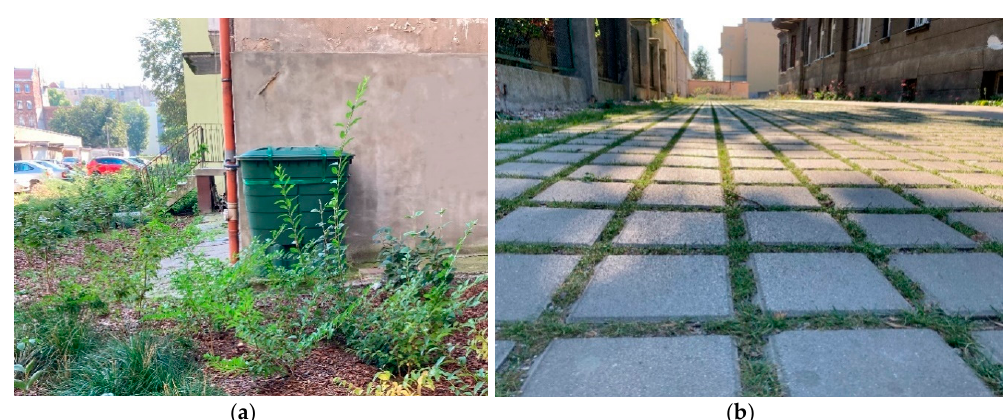
Figure 2. Selected nature-based solutions (NBSs). ( a ) Rainwater tank—a tank made of